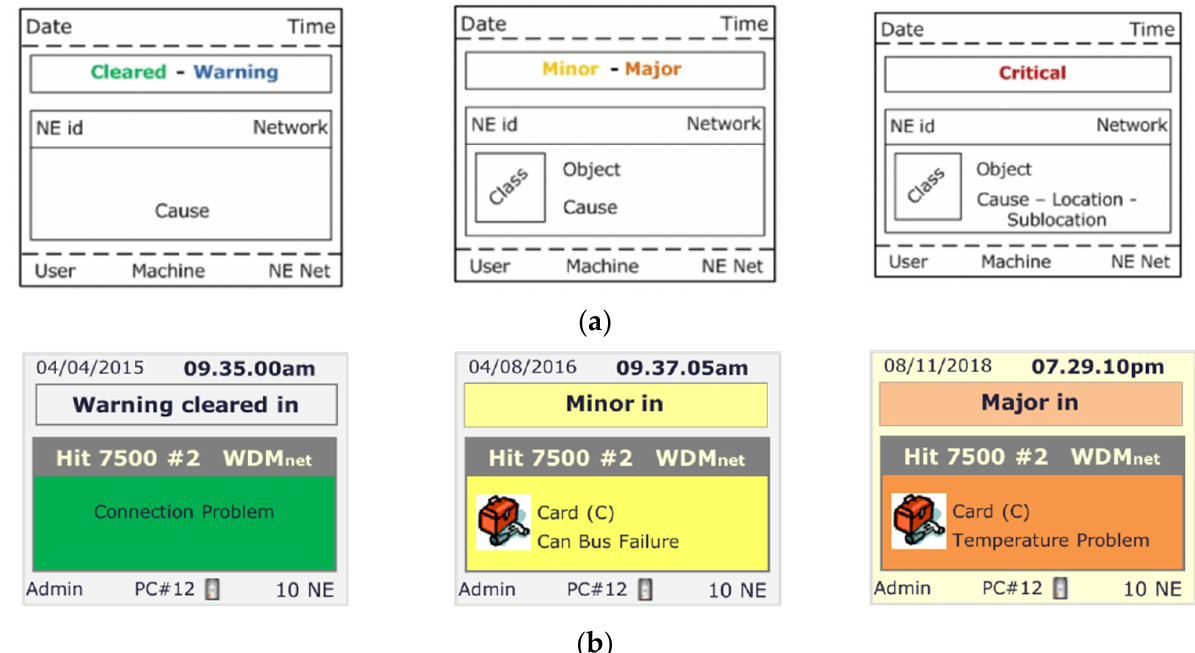
Figure 4. Application of the first GLANCE model to fault notification: ( a ) Mapping the five severity levels onto three abstract schemata and ( b ) sample fault notifications with different severity levels.